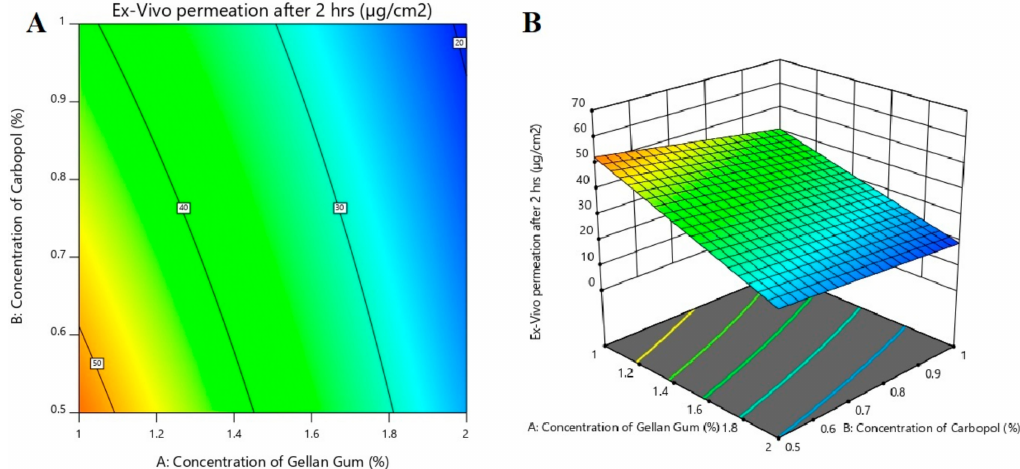
Figure 7. E ff ect of independent variables on ex vivo permeation (%) using contour plot ( A ) and 3d response surface plot ( B